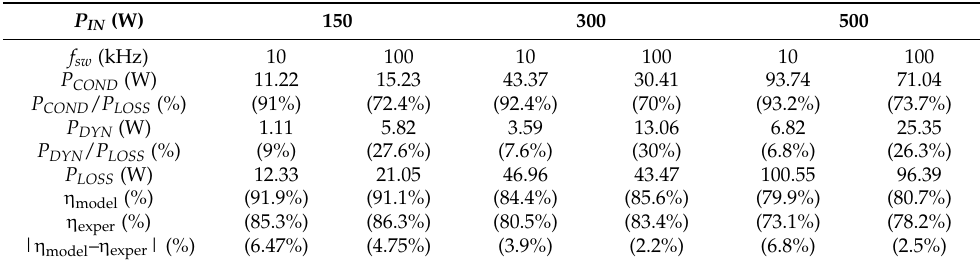
Table 2. Power loss and efficiency of push–pull converter.